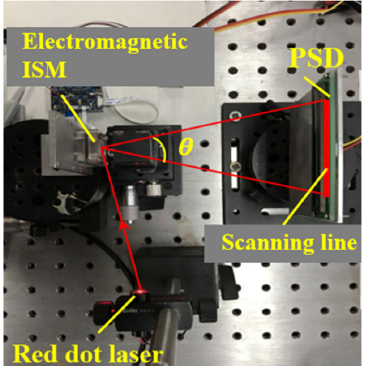
Figure 4. Test setup of the electromagnetic ISM.